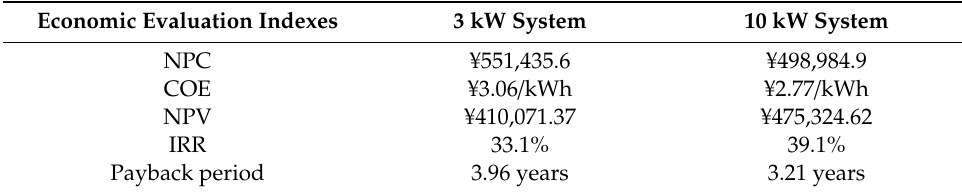
Table 3. Comparison of evaluation